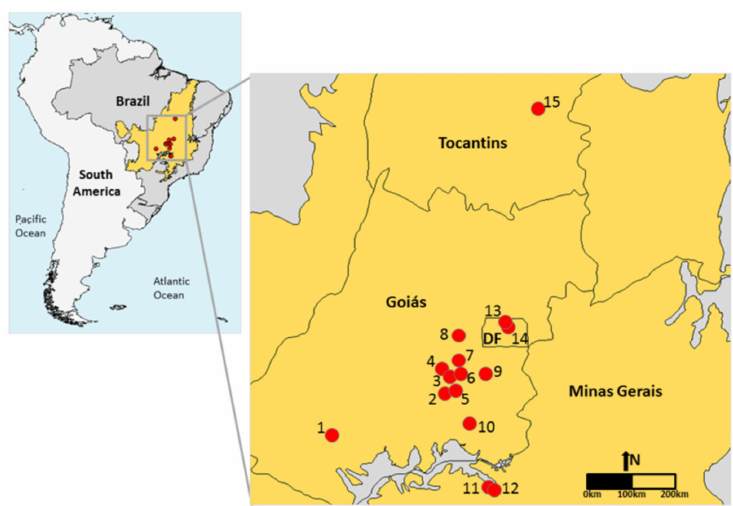
Figure 5. Location of the 15 areas of Neotropical savanna (red points) sampled in the Cerrado biome (orange area) in Brazil. Codes correspond to the areas indicated in Table